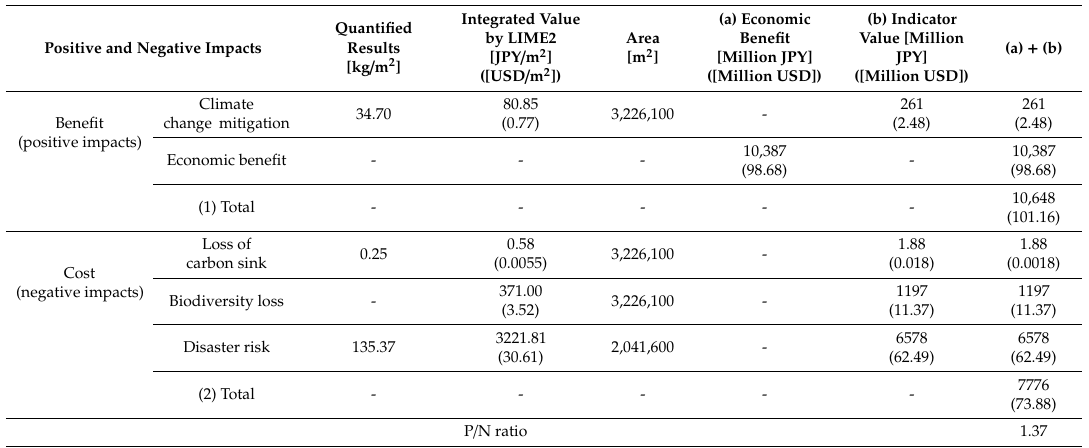
Table 6. Annual indicator